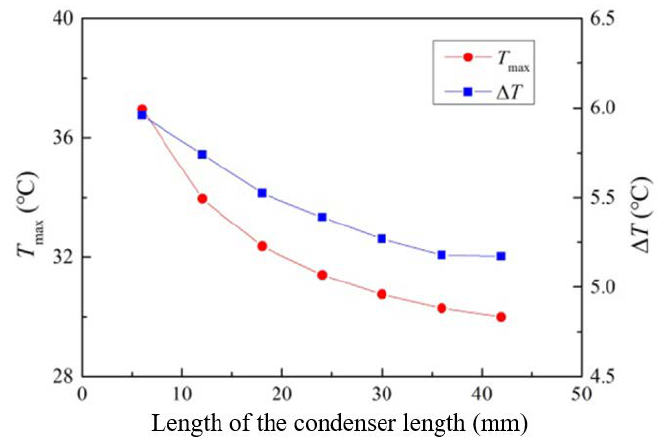
Figure 12. T max and ∆ T of the battery pack at a 2 C discharging rate with different condenser lengths (from Gan et al. [41], with permission from Elsevier).